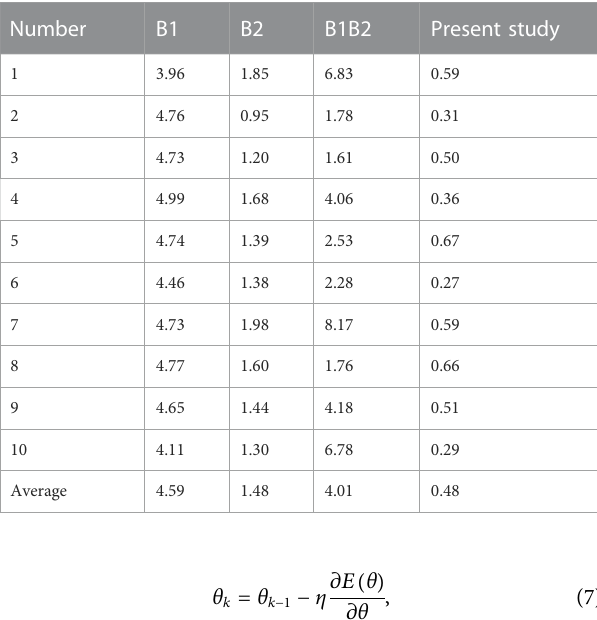
TABLE 1 Test error in the experiments